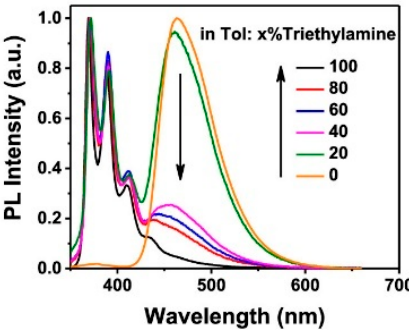
Figure 10. The normalized PL spectra of 43 in toluene and triethylamine mixed solution with different triethylamine fractions. Adapted with permission from [54], Copyright 2019, American Chemical Society .